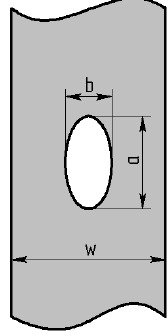
Fig. 6. Defect – horizontal